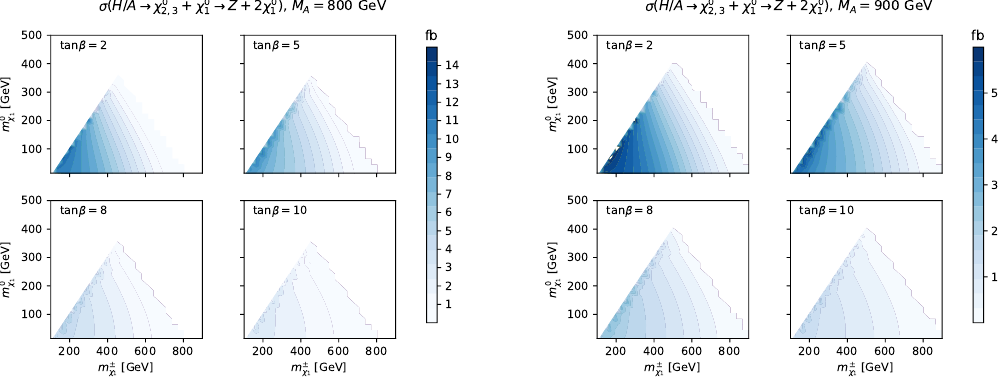
Figure 10 . The production cross-section for the process H=A electroweakinos, with heavy scalar mass m A = 800 ; 900 GeV and tan (cid:12) = 2 ; 5 ; 8 ; 10.